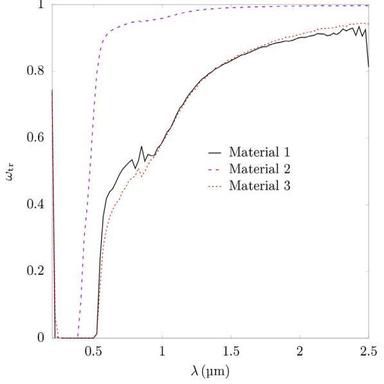
Transport scattering albedo of materials 1–3.